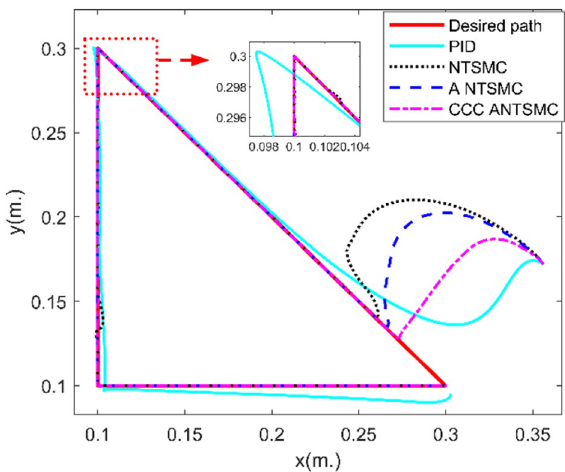
Figure 8. Contour tracking error of the